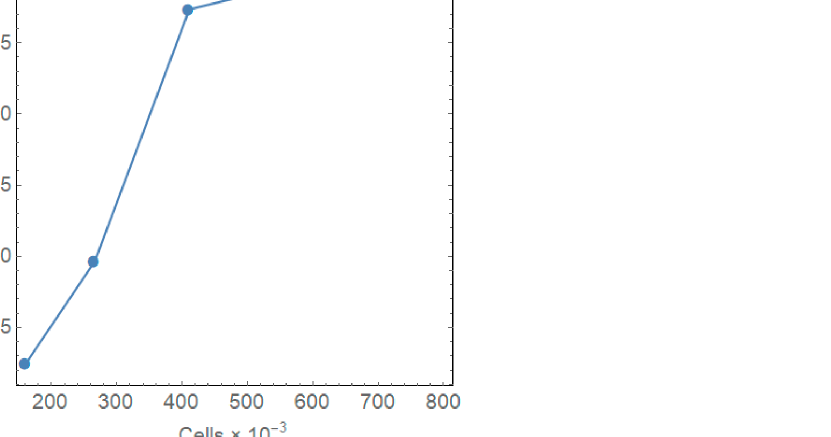
Figure 2. Dependence of the maximum concentration on the domain symmetry surface on the number of cells.